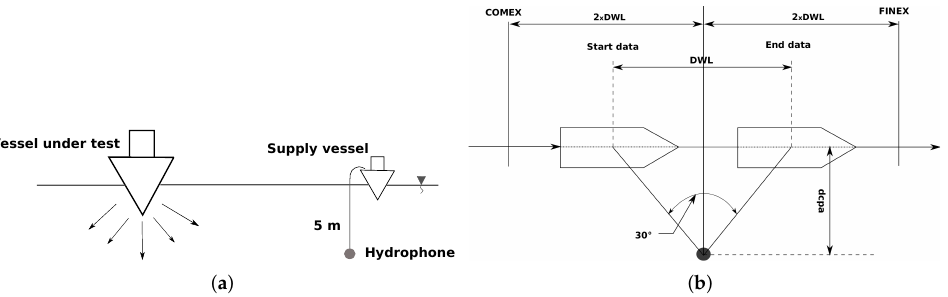
Figure 1. Measurement geometry for the ship-radiated underwater sound received on a vertical hydrophone array, in ( a ) side view and ( b ) top view. The straight line distance traversed by the target ship while the data was being recorded is represented by DWL. The horizontal distance from the target ship to the hydrophone at the closet point of approach is represented by dcpa. (DWL = 136.9 m, dcpa = 118.6 m).